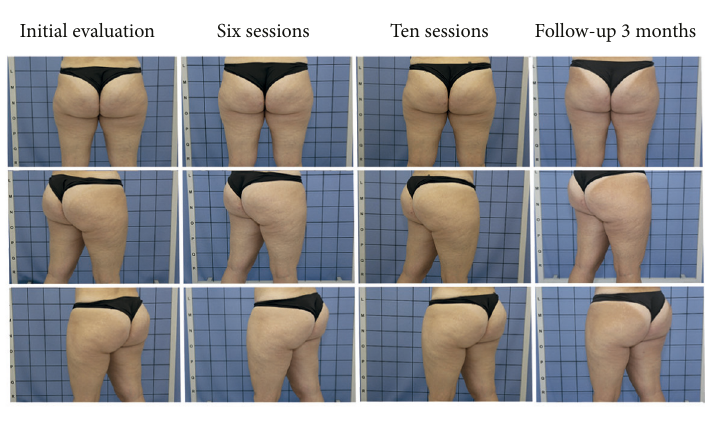
Figure 2: Improvement of the degrees of cellulite in different views in the comparison of the photos throughout the evaluations and reevaluations.